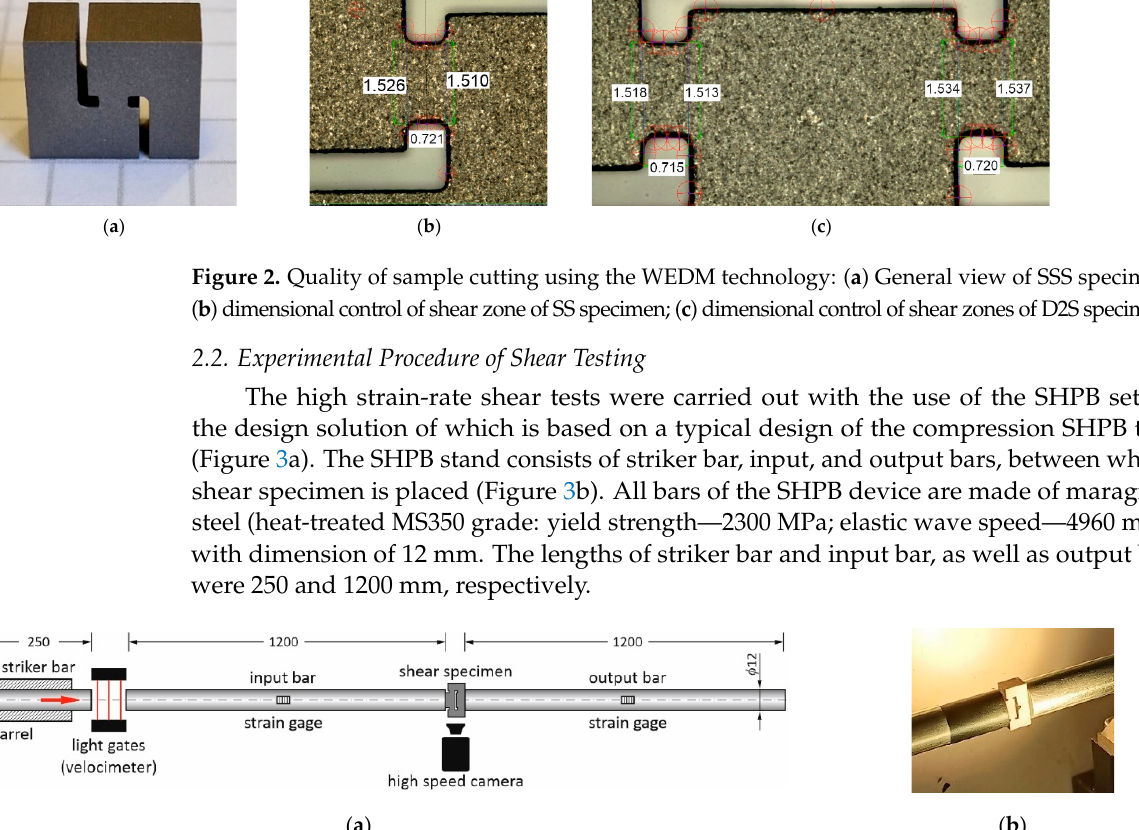
Figure 2. Quality of sample cutting using the WEDM technology: ( a ) General view of SSS specimen; ( b ) dimensional control of shear zone of SS specimen; ( c ) dimensional control of shear zones of D2S specimen.